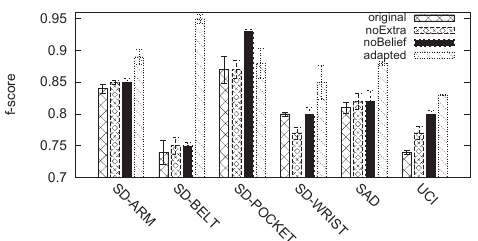
Figure 6: Proportion of weak learners trained on new features during the retraining process across the datasets.